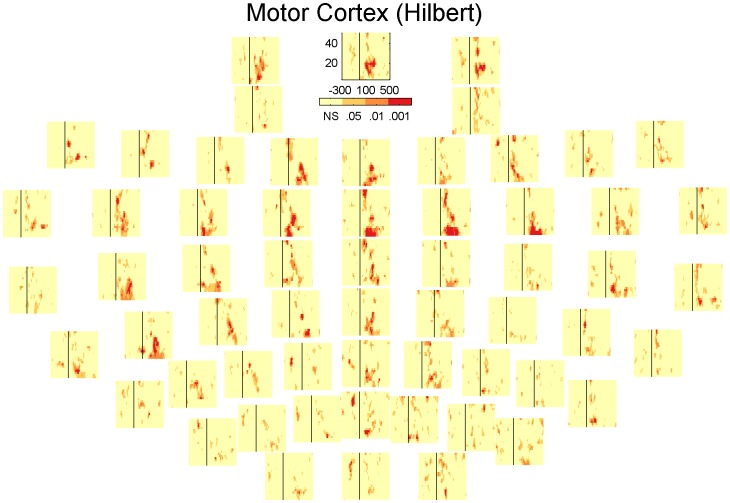
Statistical significance of each sample in the TF-maps of LICIHT for MC corresponding to each specific electrode.